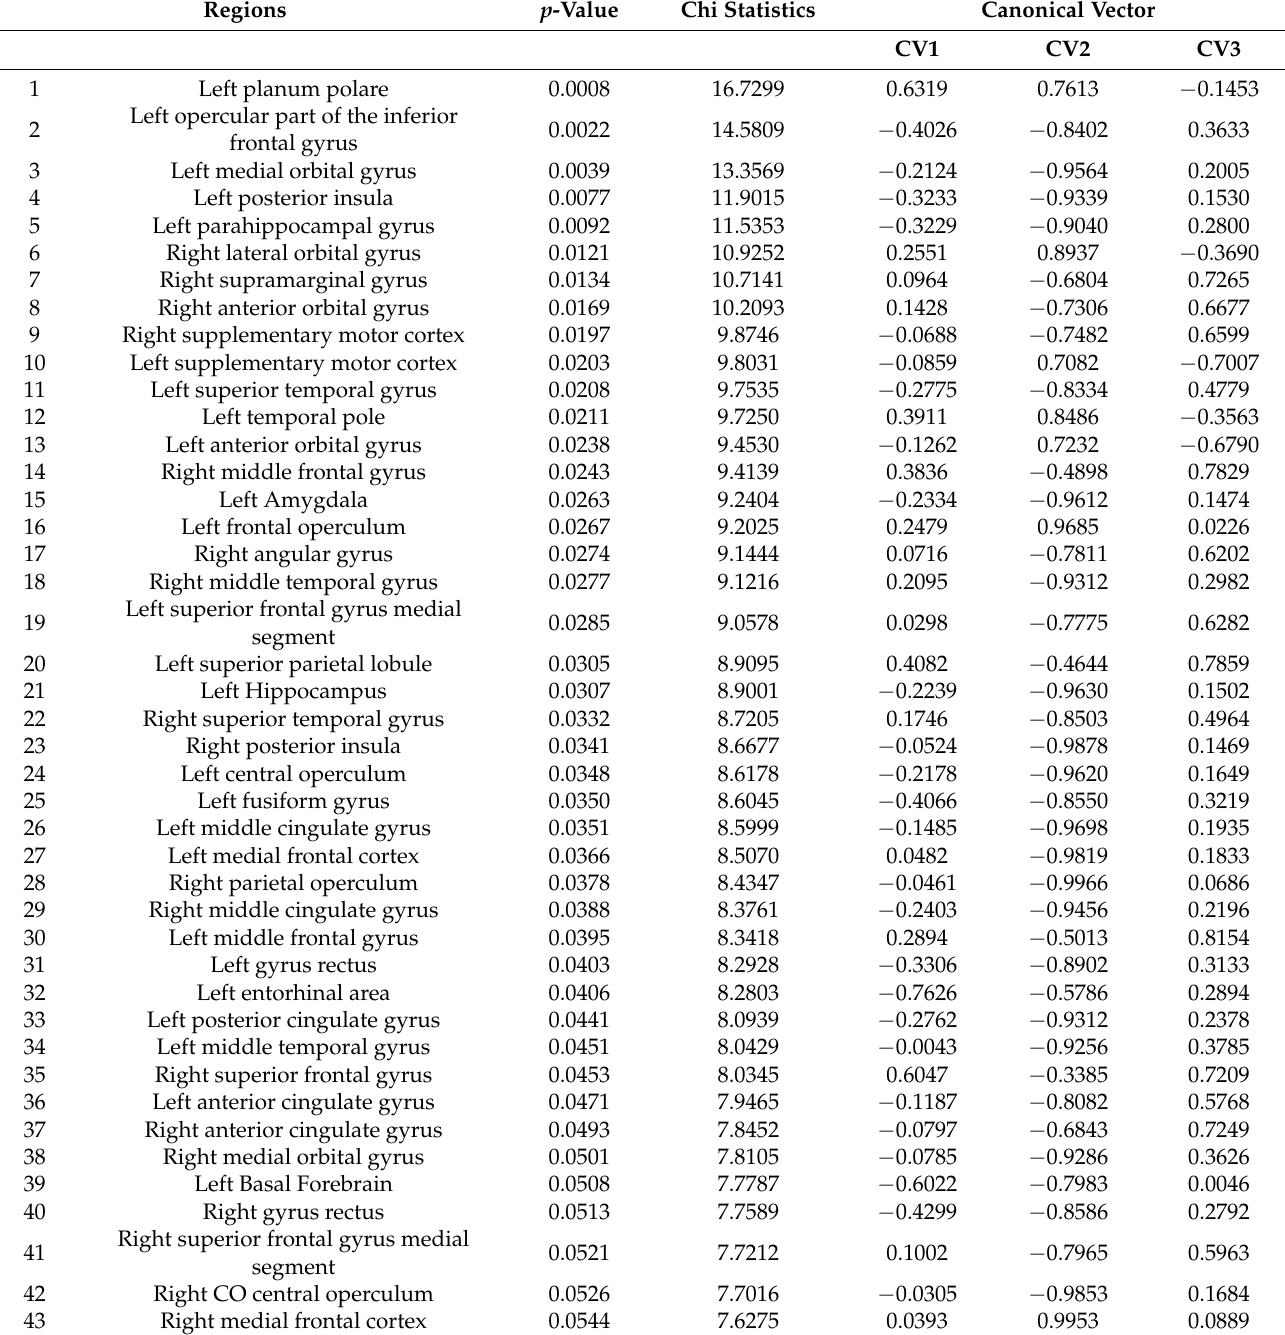
Table 2. Significant regions and their canonical